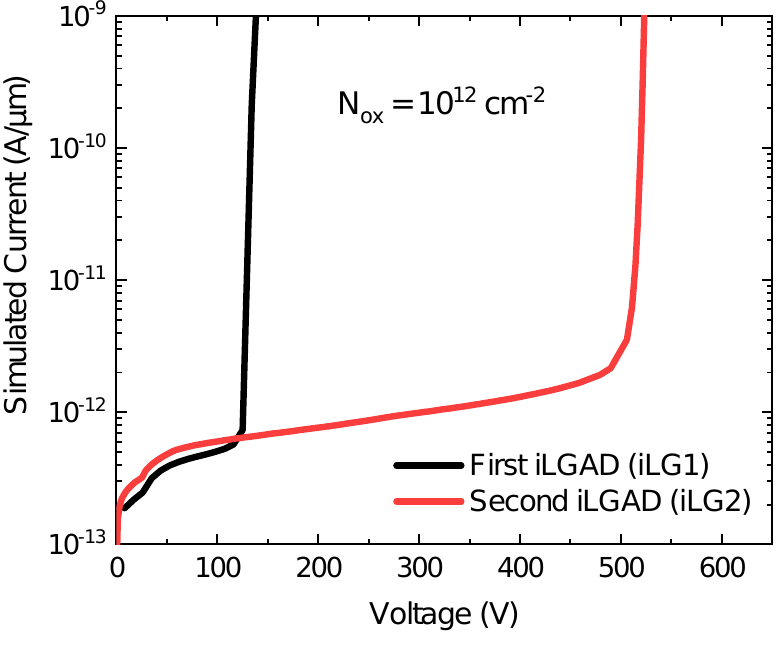
Figure 6. I-V simulation of iLGAD structures with N ox = 10 12 cm − 2 . The initial and the optimized designs are included to show the significant increase in the breakdown voltage (almost four times).